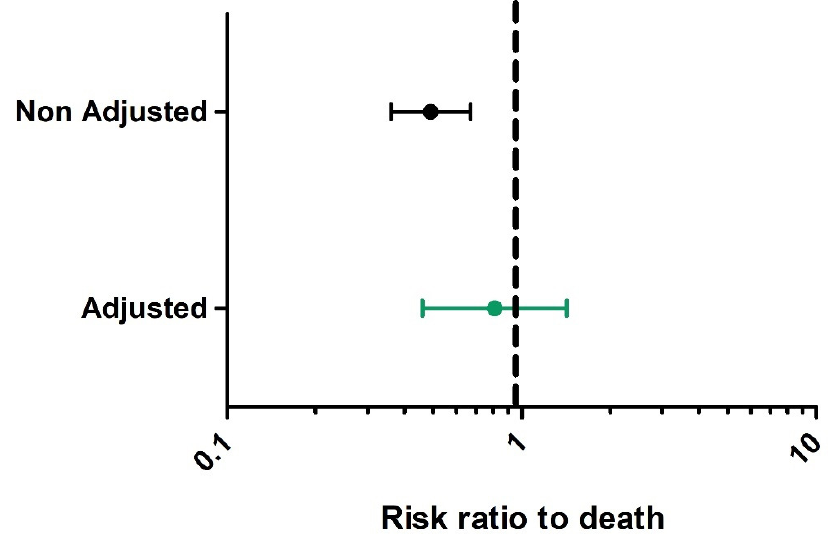
Figure 2. Black caterpillar plot represents overall risk ratio to death before inverse probability of treatment weighting. Green caterpillar plot represents risk ratio to death after inverse probability of treatment weighting.